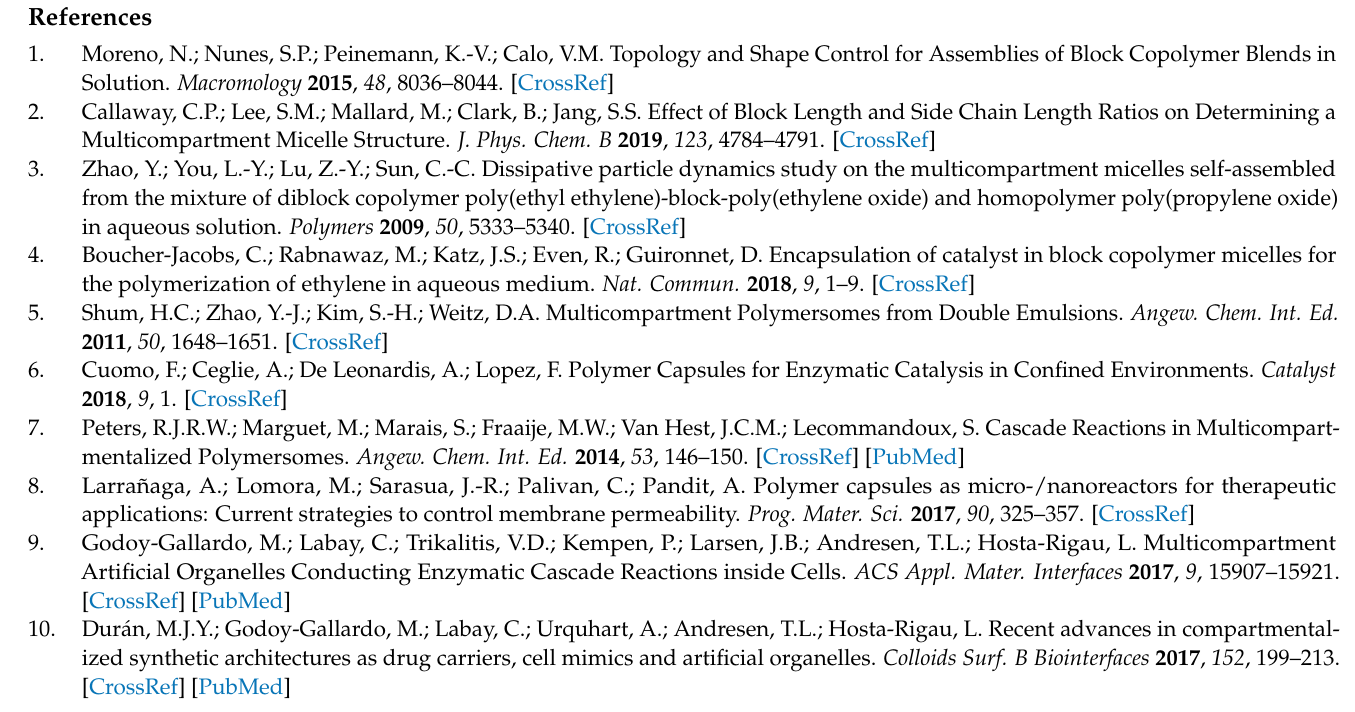
dimensionless order parameter ϕ , Figure S4: Time evolution of the polydispersity index versus time, Table S1: Morphological characteristics of the aggregates formed in the (100 R c ) 3 simulation